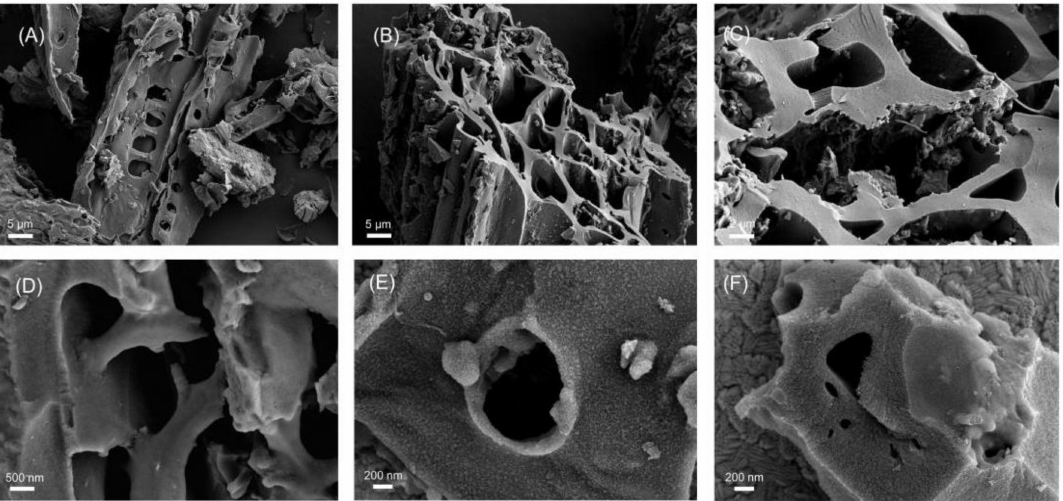
Figure 2. SEM images of TBC ( A ), K-TBC ( B , C ), K-TBC/ITO ( D ), NOR-MIP/K-TBC/ITO ( E ) and MIP/K-TBC/ITO ( F